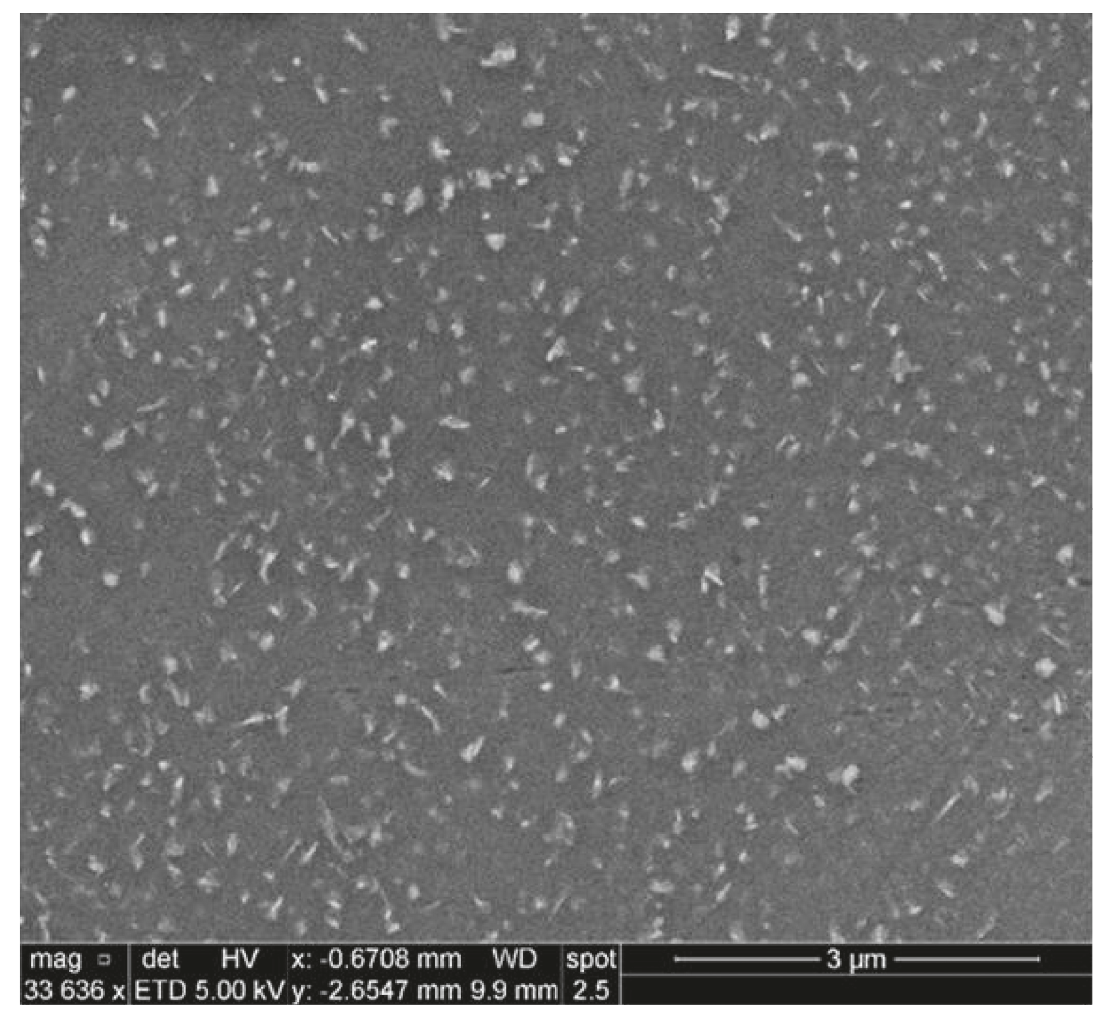
Figure 4: Micrograph of T7 heat-treated alloy B tested at ambient